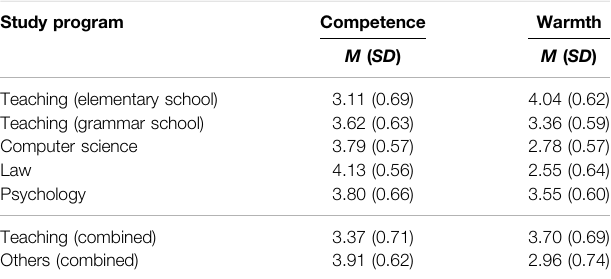
TABLE 1 | Competence and warmth ratings of pre-service teachers and other students in different study programs in Study 1. Study